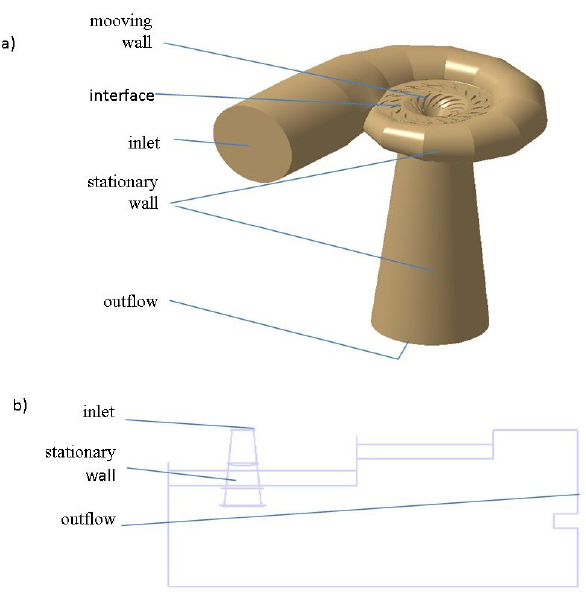
Figure 2: Computational model: a) turbine, b) outlet chamber